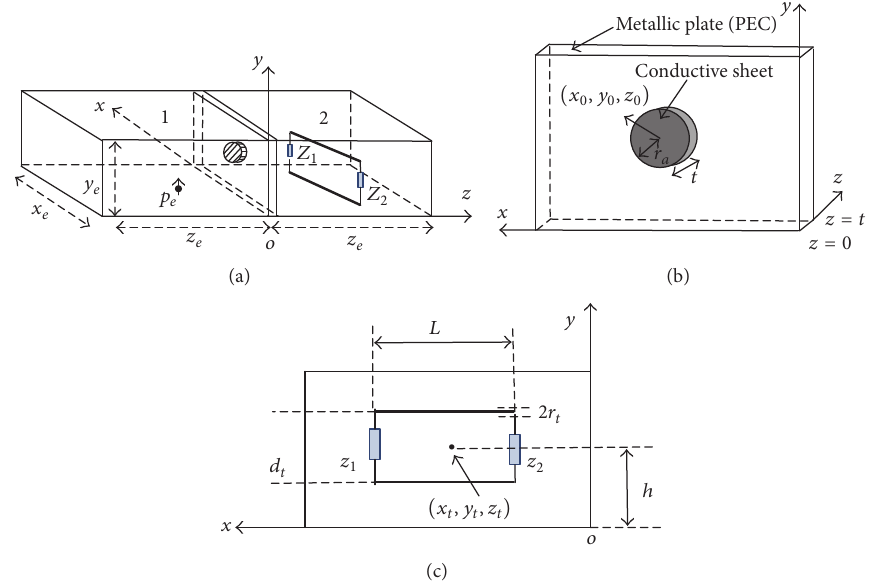
Figure 1: (a) Two adjacent metallic rectangular enclosures connected by a metallic plate with an aperture covered by a conductive sheet excited by an electric dipole in enclosure 1 and containing a two-conductor TL in enclosure 2. (b) The geometry of the metallic plate with the covered circular aperture. (c) The side view of the TL corresponding to